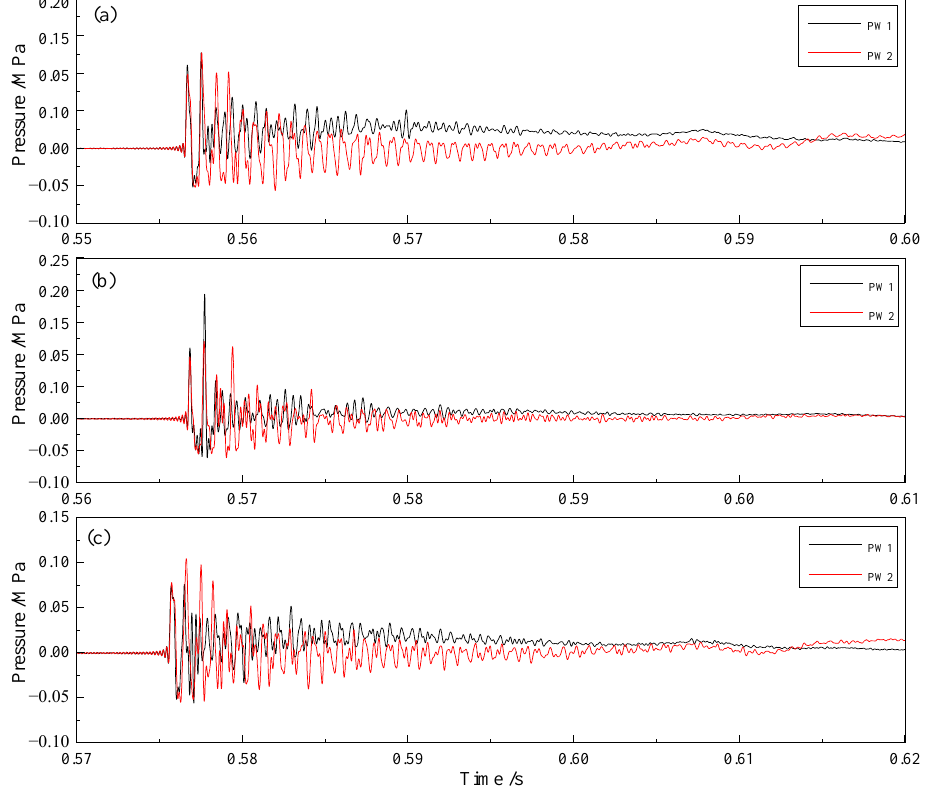
Figure 15. Curves of the pressure signals when different nozzles were installed: ( a ) StraightN0, ( b ) ShrinkingN20, and ( c ) ExpandingN20.